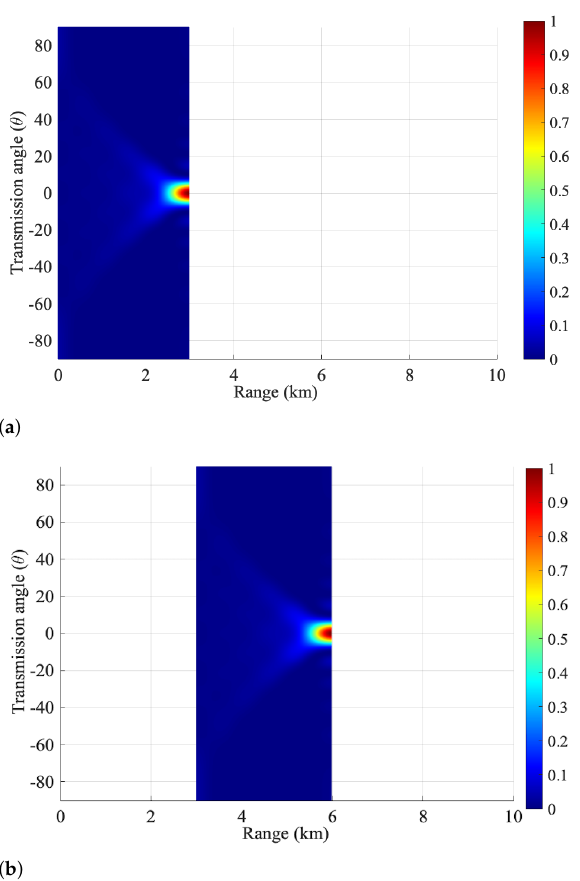
Figure 5. Beam focusingin the FDA-WPT system at ( a ) t = 10 µ s, ( b ) t = 20 µ s. When the receiving end consists of just one antenna, the target area as shown in Figure 4 can be considered as a point ( r t , θ t , ϕ t ) in the far-field. Therefore, the integral area Ψ in (7) changes from an area to a point. As a result, the integral result of (7) is 0.